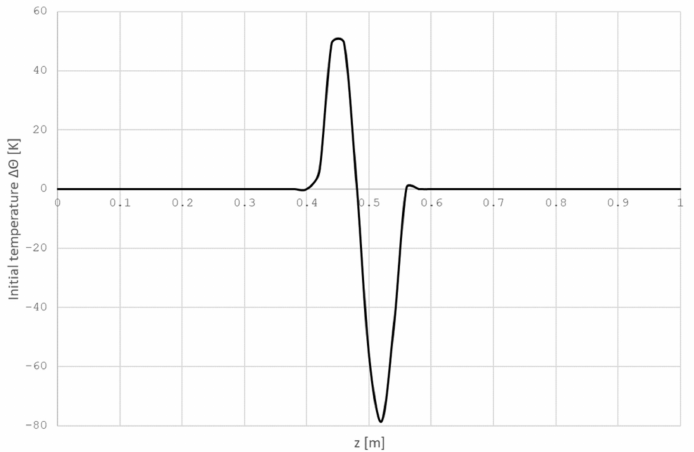
Figure 3. Initial temperature distribution ∆Θ 0